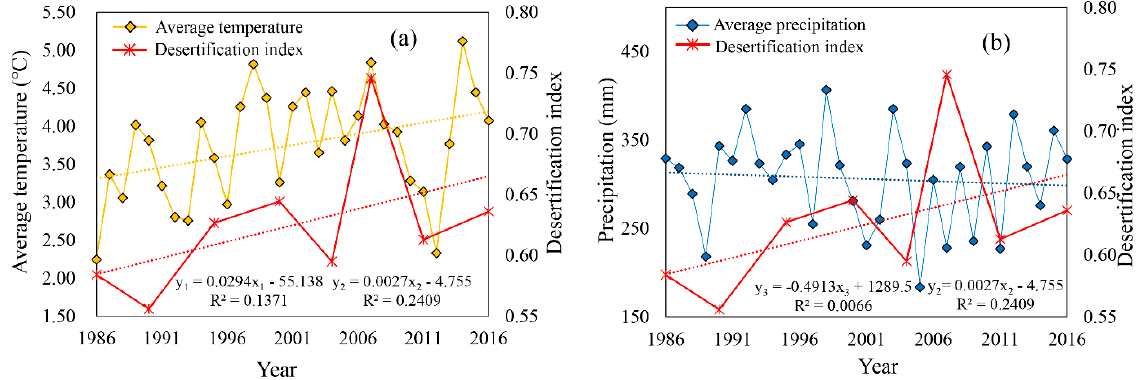
Figure 7. ( a ) Annual mean temperature and ( b ) annual precipitation at OSL from 1986 to 2016. y 1 represents the trend line of mean temperature change; y 2 represents the trend line of desertification index change; y 3 represents the trend line of mean temperature change.